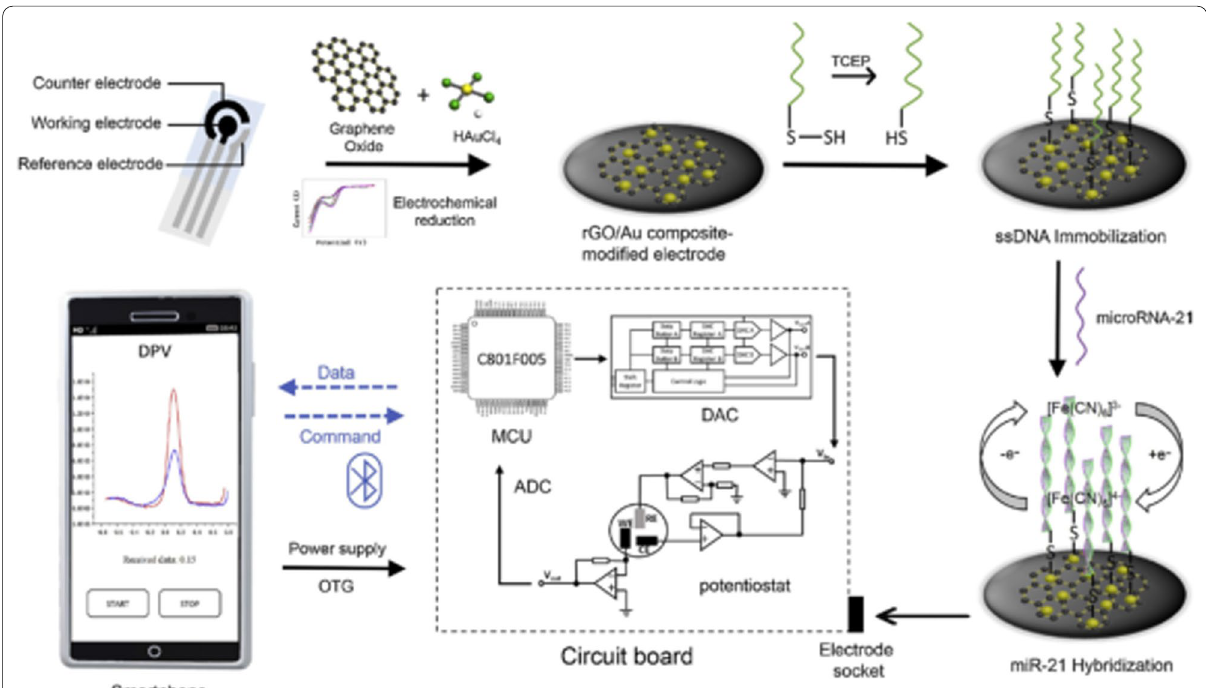
Fig. 6 Pictorial illustration of smartphone-based electrochemical biosensor platform. It contains of the composite of graphene/gold-modified sensing electrode, circuit board and smartphone with operating system of Android application for sensing miR-21 (Shin Low et al.